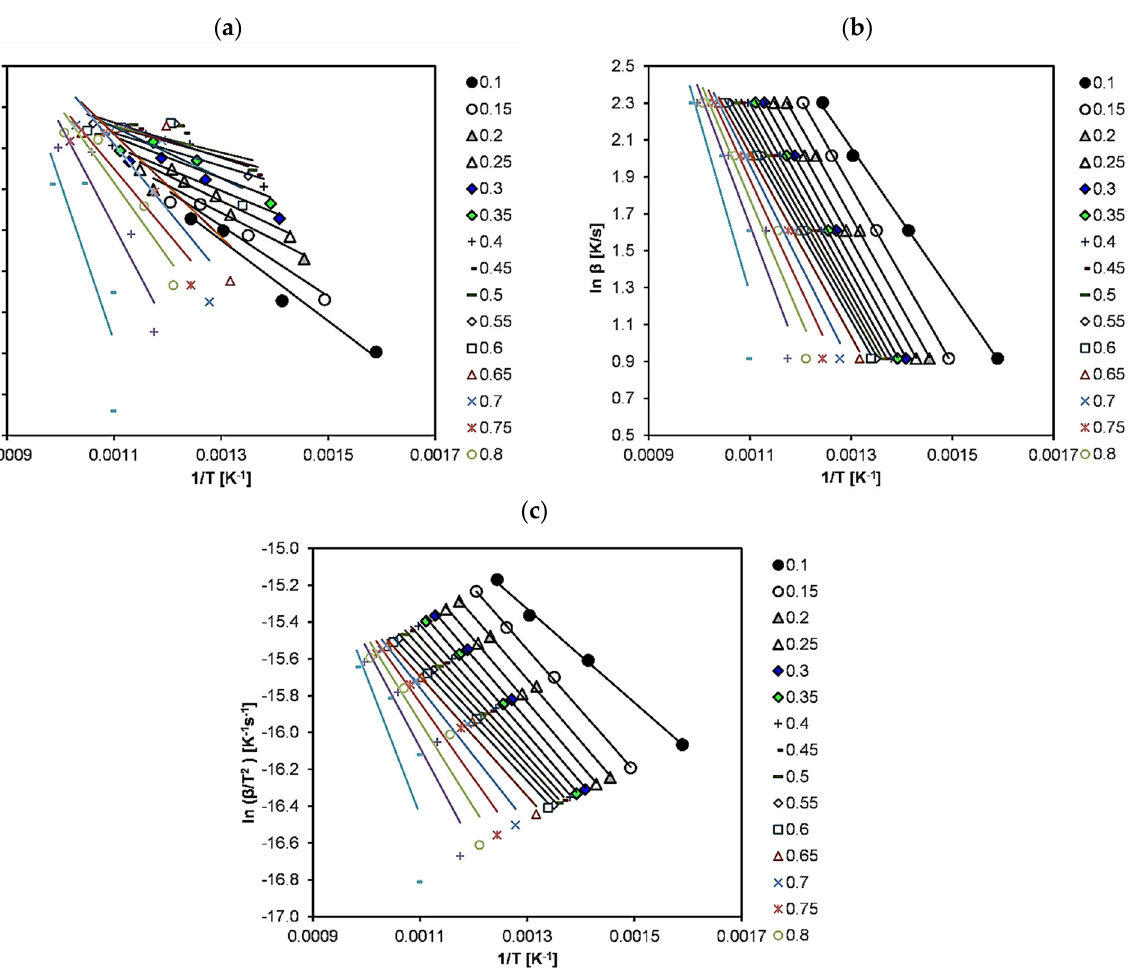
Figure 6. Linear regression of ( a ) Friedman, ( b ) FWO, and ( c ) KAS equations at different conversions.